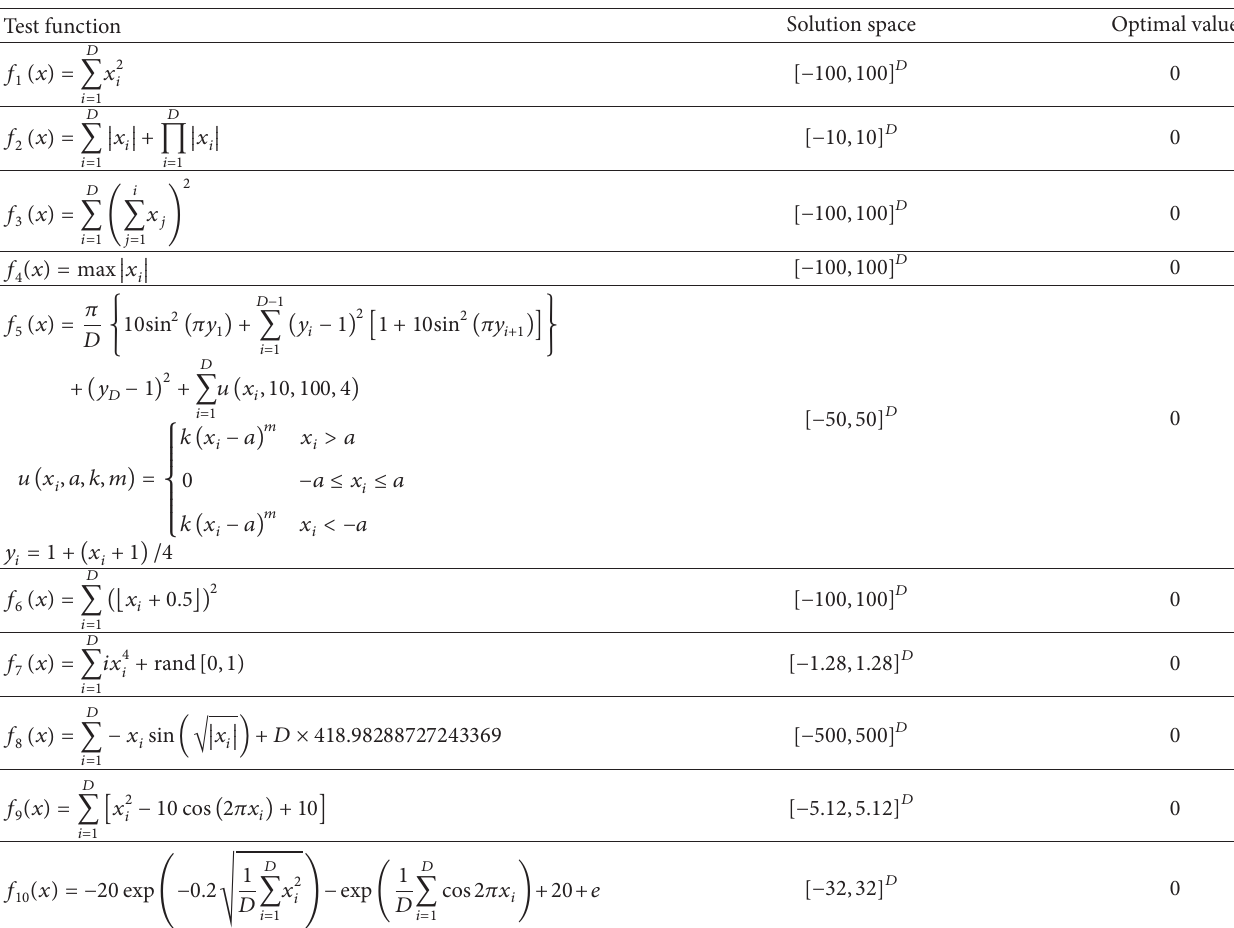
Table 1: Definition of benchmark